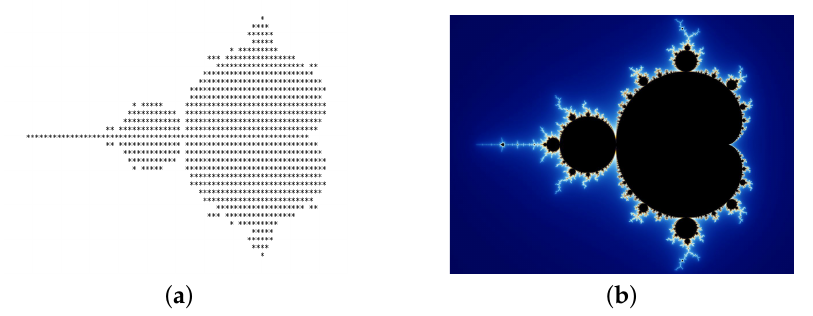
Figure 1. The Mandelbrot set: ( a ) first image (1978) and ( b ) image generated by Mandelbrot (1980). R. Brooks and P. Matelski published the first image (Figure 1a) of the Mandelbrot set